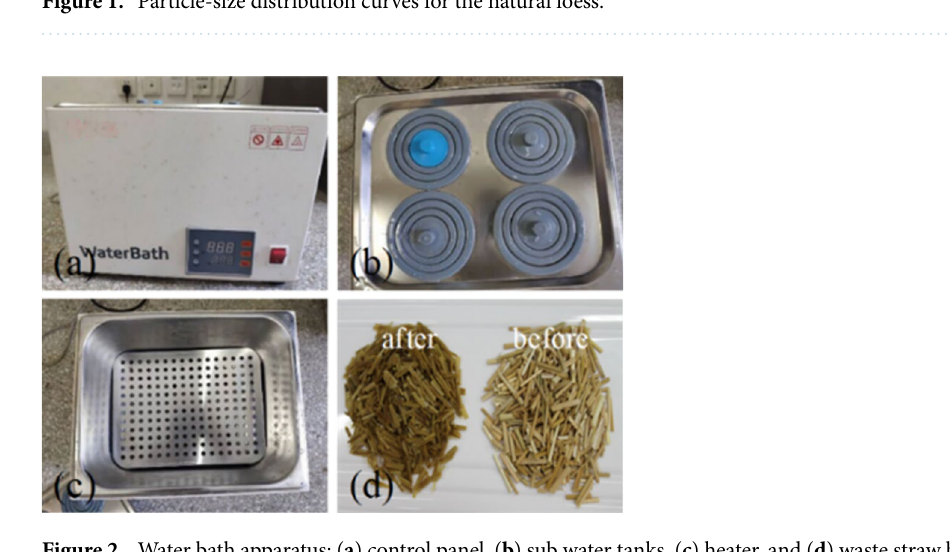
Figure 2. Water bath apparatus: ( a ) control panel, ( b ) sub water tanks, ( c ) heater, and ( d ) waste straw before and after the boiled water treatment.